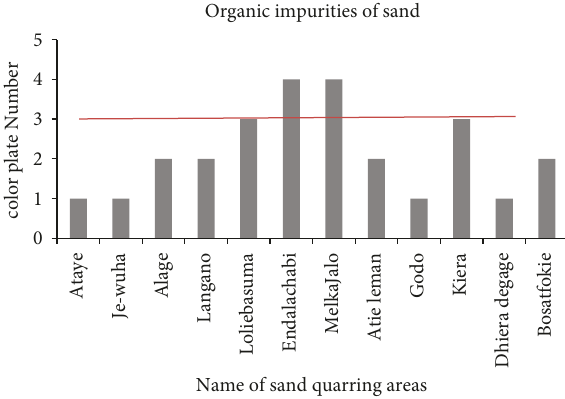
Figure 10: Organic impurities (source: test results). Table 3: Organic plate number Table 4: Color value of sand at each quarry Gardner color standard no.